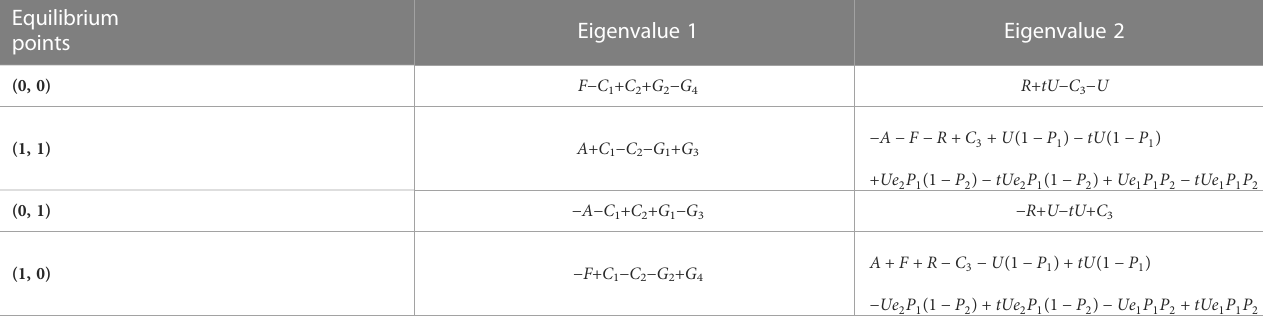
TABLE 6 Eigenvalues of Jacobian matrix J (second stage). Equilibrium points